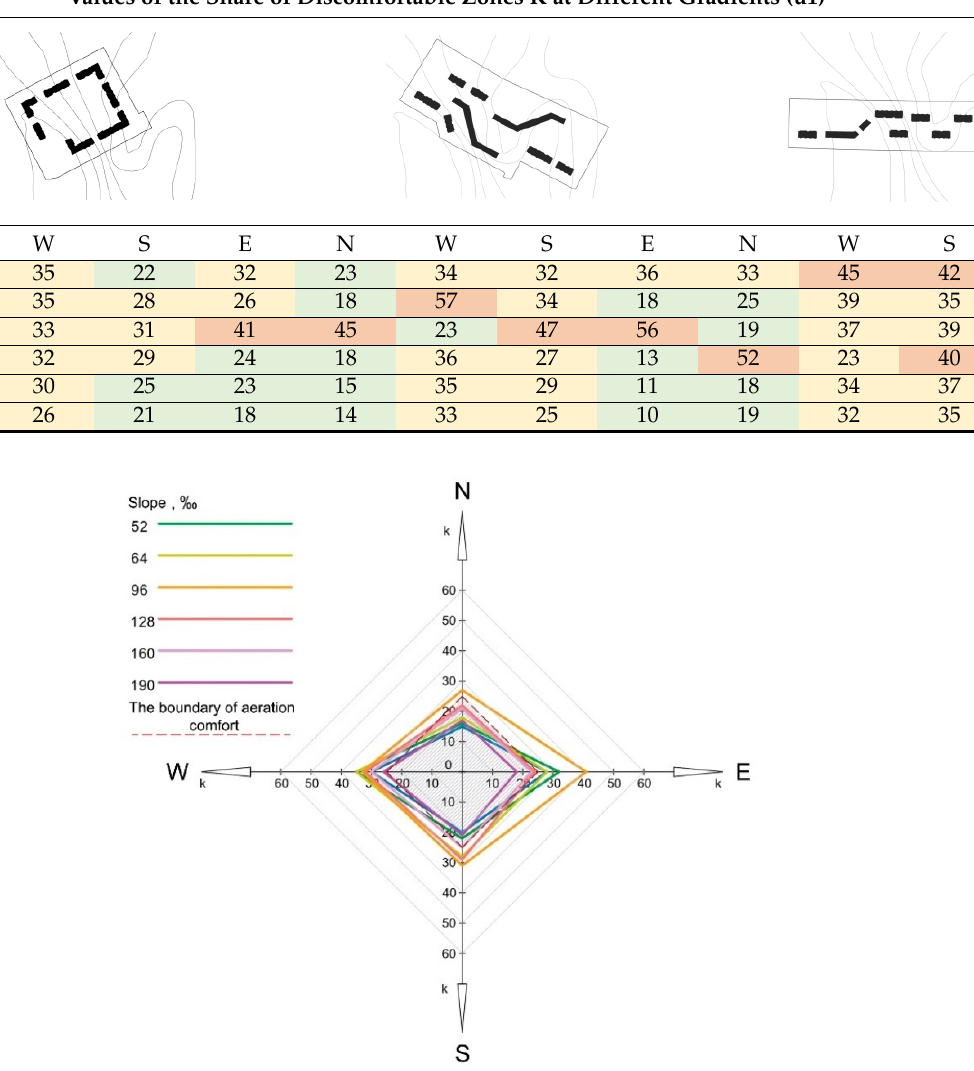
Figure 16. The petal diagram showing the breakdown of the share of discomfortable zones k for the perimeter type of development, gradients from 52–190‰, and four exposures of the slope. The petal diagram for the perimeter morphotype of development shows that the most discomfortable slope has eastern exposure and a gradient of 96‰ (Figure 16). For the western exposure, all values of the share of discomfortable zones vary between 26% and 35%. The northern exposure of the slope is most comfortable for the perimeter morphotype of